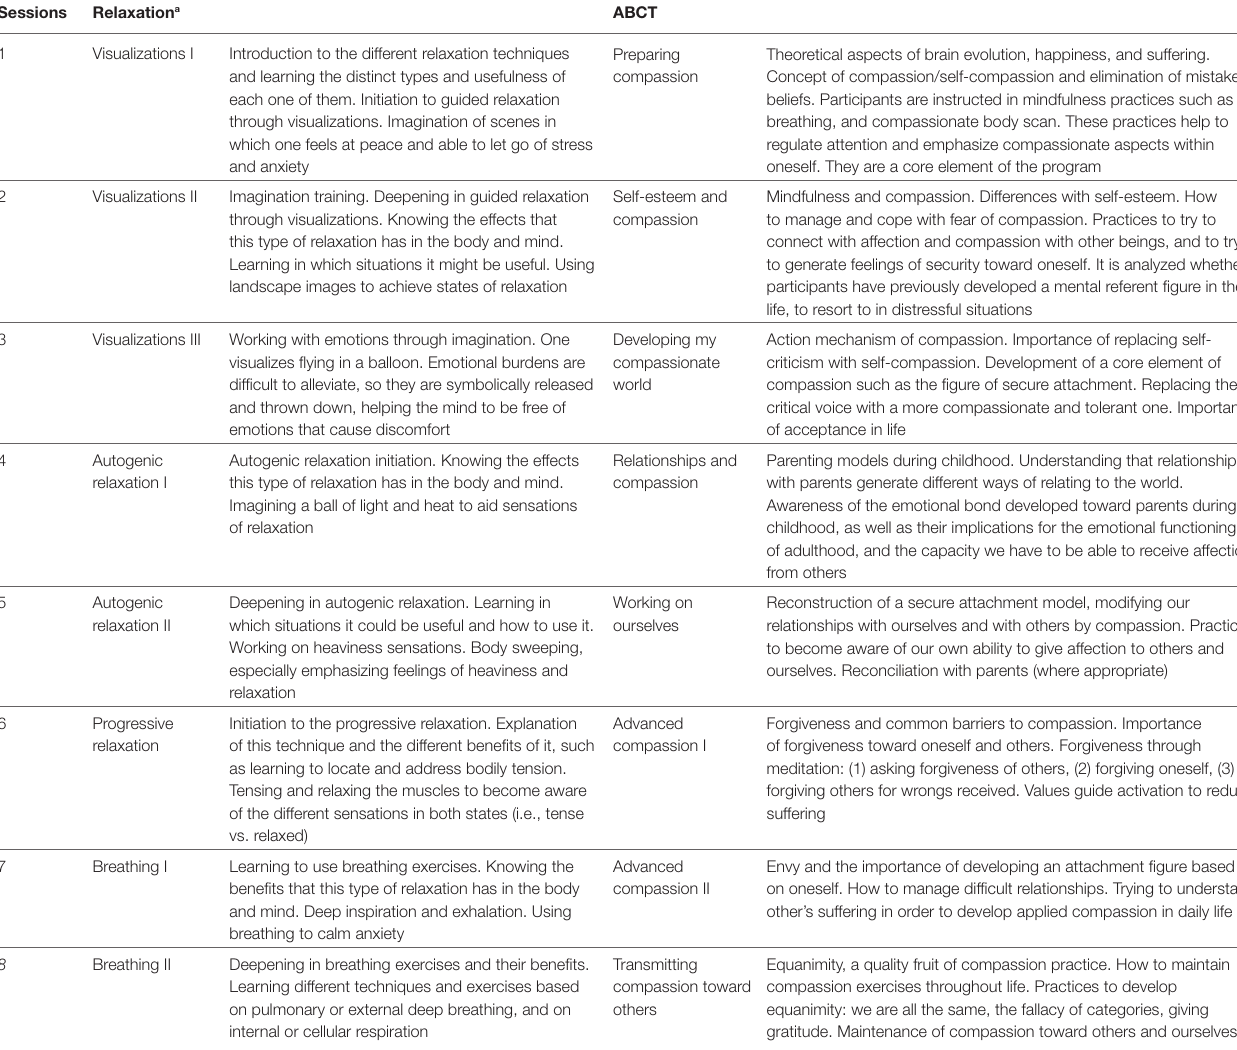
TaBle 1 | Session outlines for the treatment